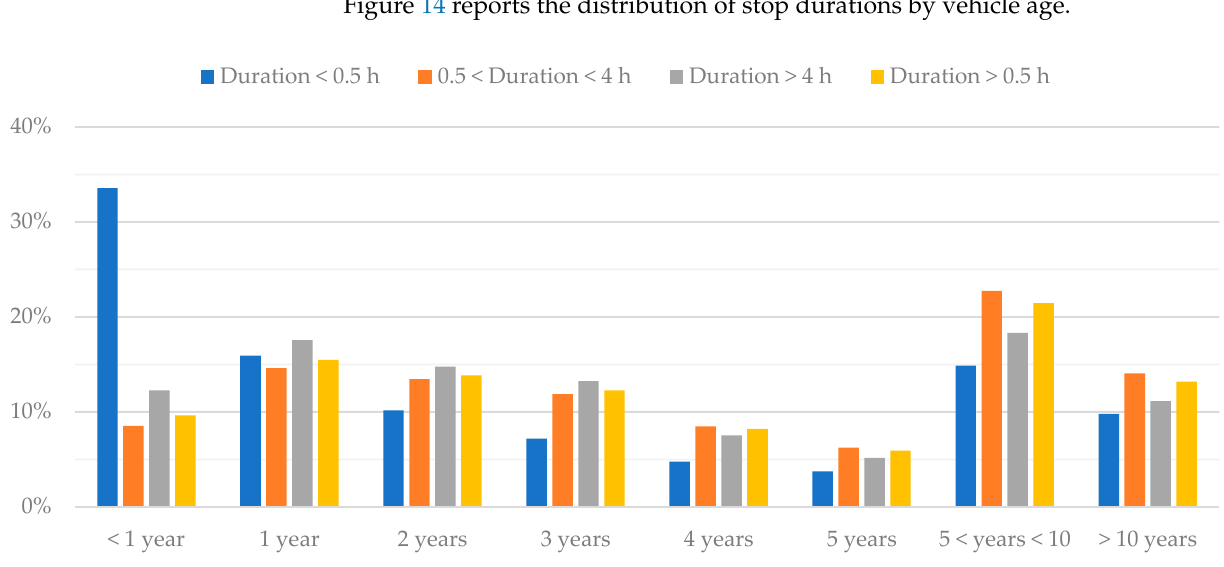
Figure 14. Distribution of stop duration by vehicle age.